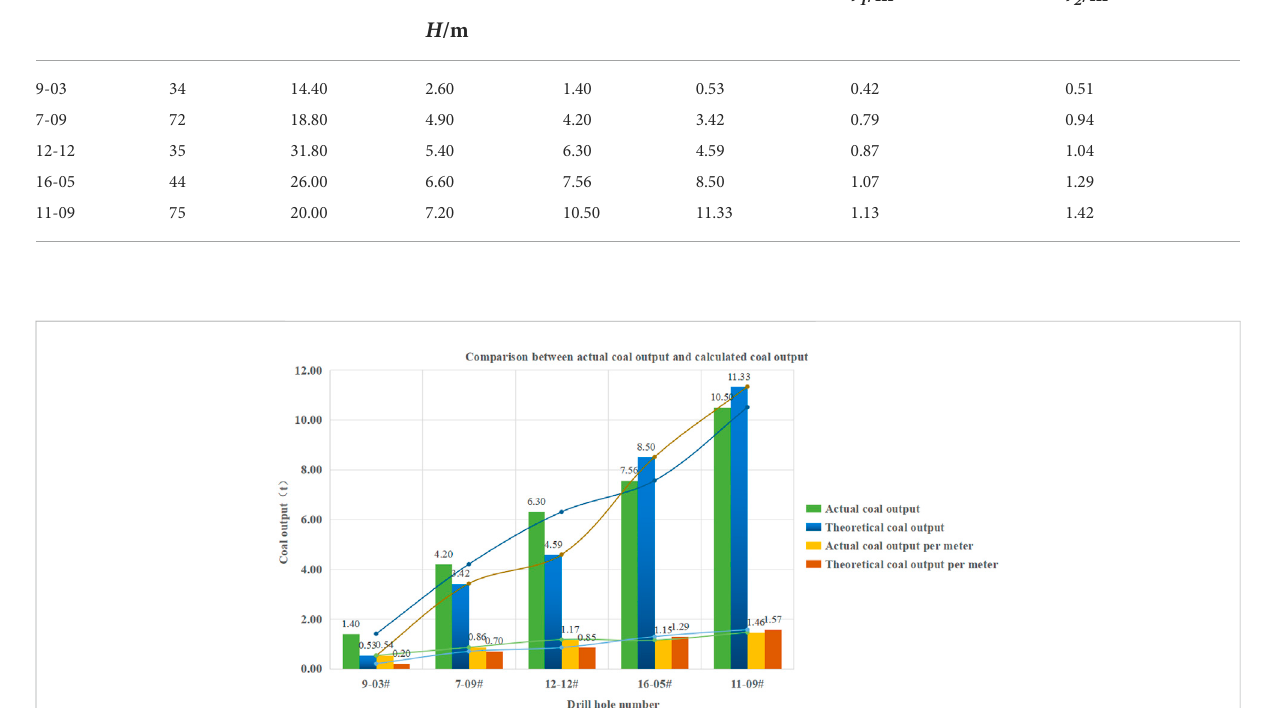
TABLE 2 Hydraulic fl ushing drilling parameters. Borehole no.